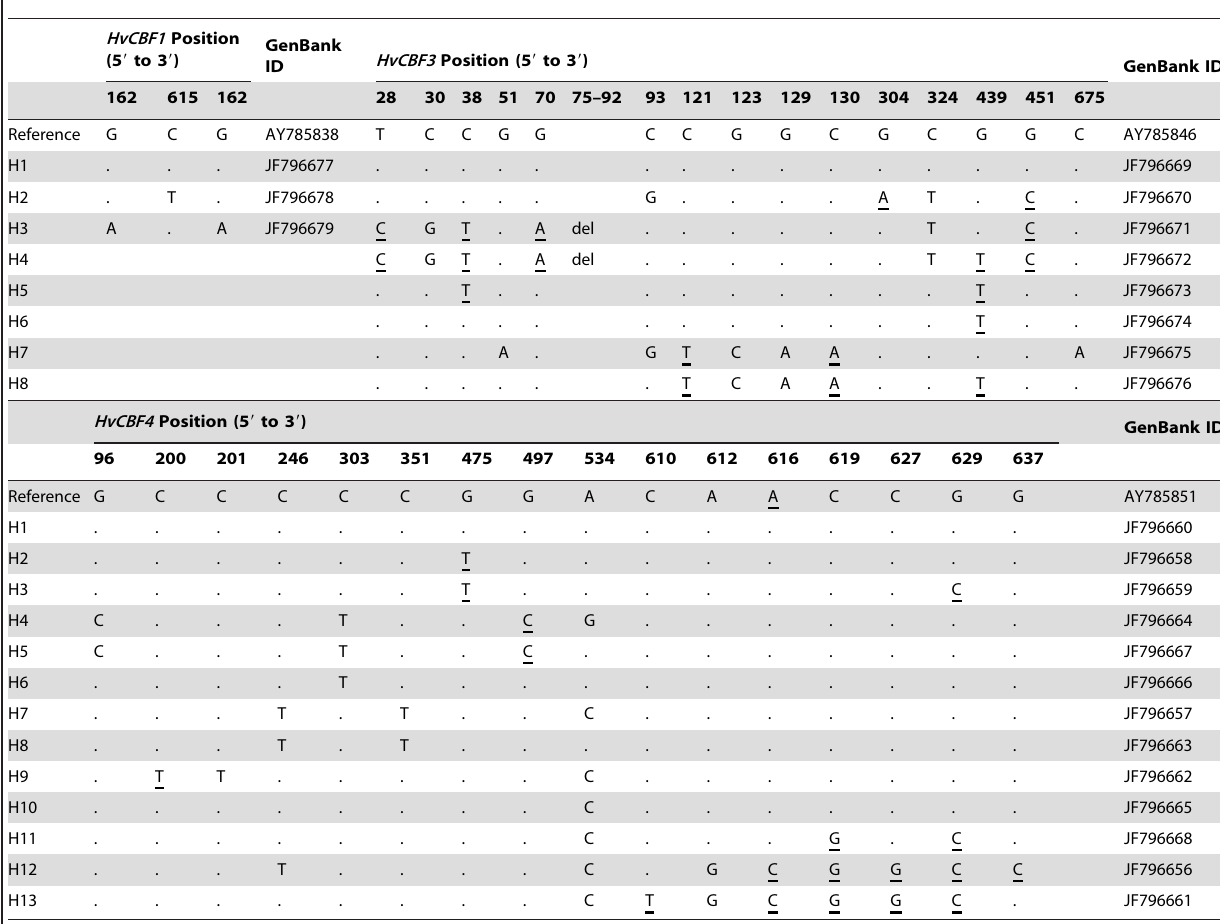
Table 1. Single nucleotide polymorphisms (SNPs) and haplotype pattern of HvCBF genes in Tibetan